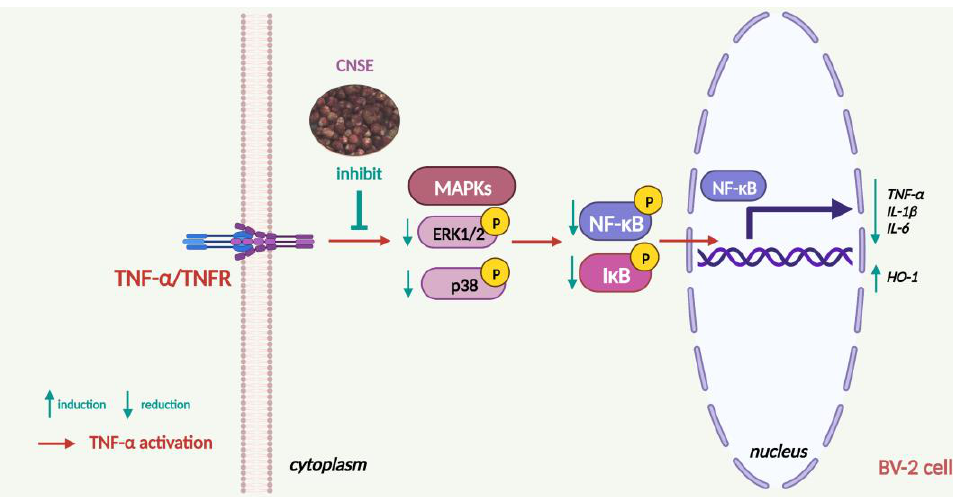
Figure 10. The proposed schematic overview of the effects and molecular mechanism of CNSE on protecting TNF-α-induced neuroinflammation in BV-2 mouse microglial cells (created by BioRen- der.com).